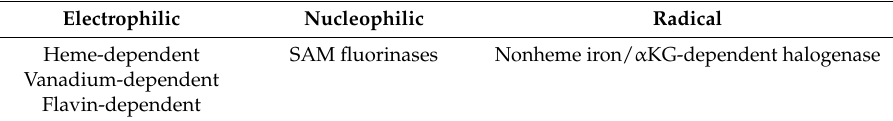
Table 1. Classification of the halogenases according to the nature of their active halogenating agent.